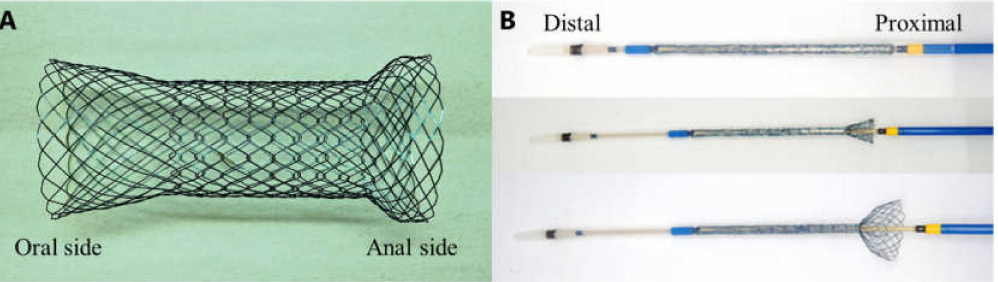
Figure 1. The newly developed proximal release-type colonic stent. ( A ): The diameter and length of this new stent were 22 and 70 mm, respectively. It has flares at both ends to prevent migration. ( B ): The stent was mounted on a 16 Fr delivery system and was released from the proximal side.